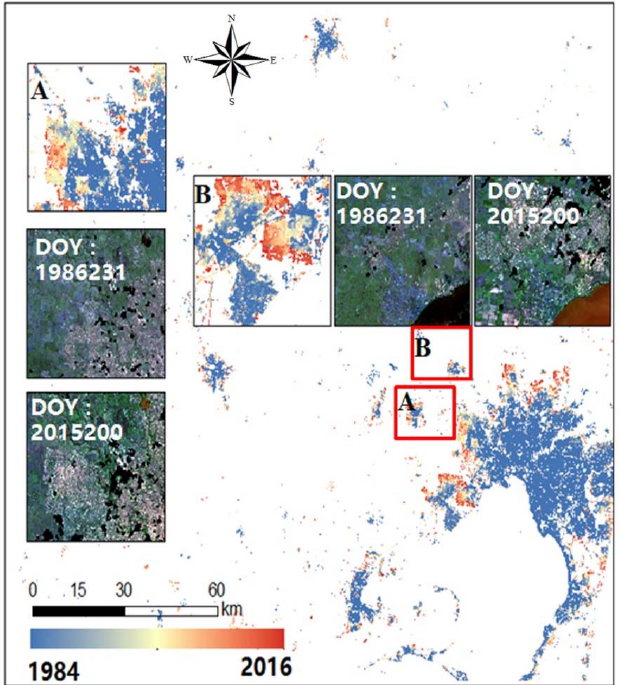
Figure 10. Urban expansion during 1984–2016 in Melbourne, with insets providing magnified views of ( A ) Willerby and ( B ) Hume. TM images corresponding to the beginning and end of the analysis period are also shown.